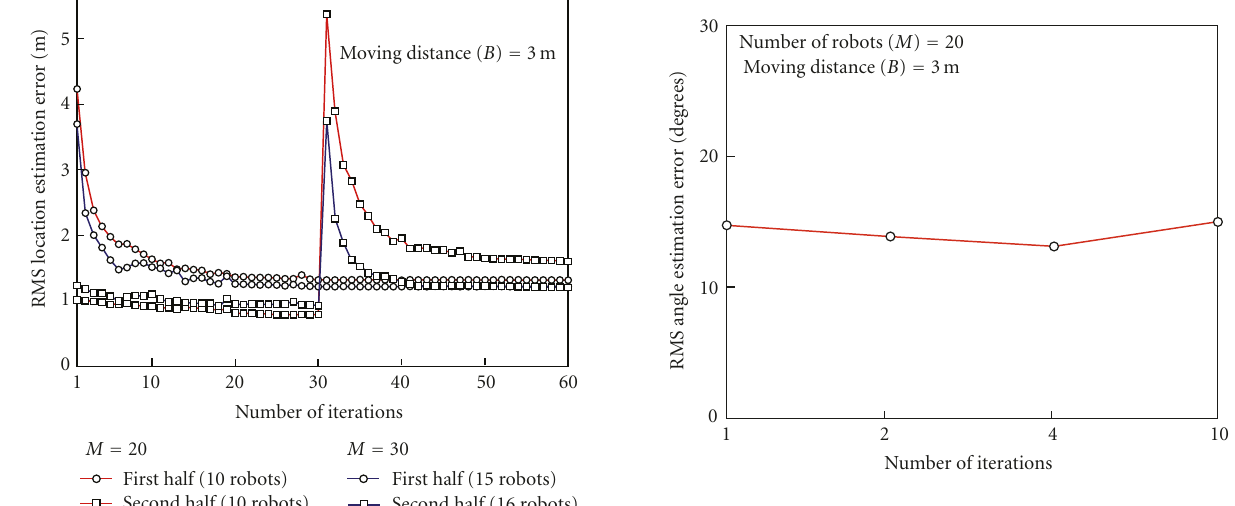
Figure 10: RMS location estimation error with respect to the number of location/direction estimation